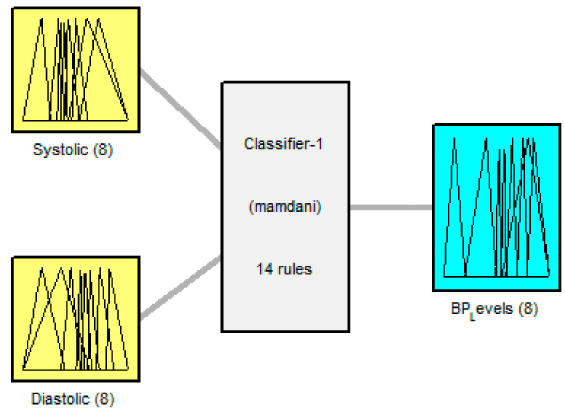
Figure 3. Structure of the fuzzy logic classifier 1.